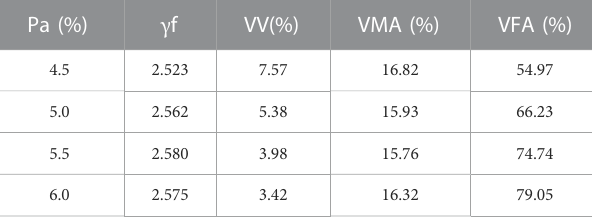
TABLE 18 Marshall test results for gradation 3.